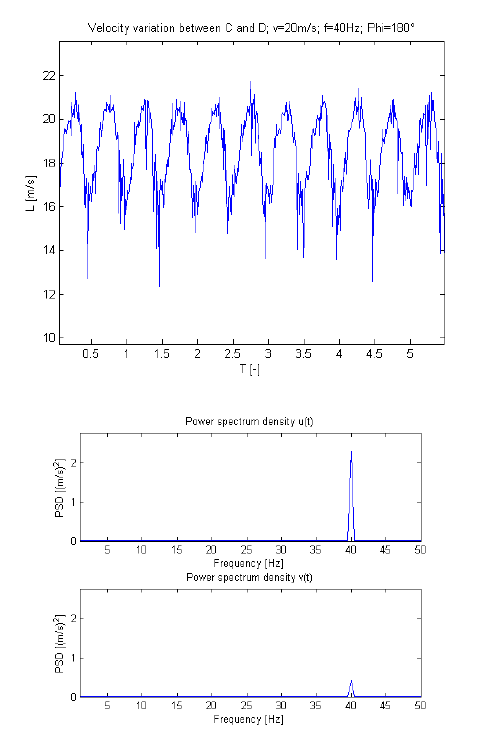
Fig. 6. Velocity variation and freq. spectra for both vel. components at point X for excited blades (compressor)